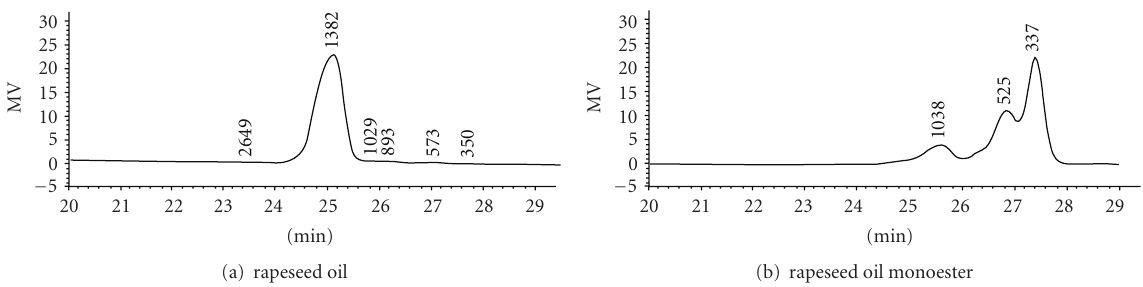
Figure 2: GPC spectrum of rapeseed oil and rapeseed oil monoester .